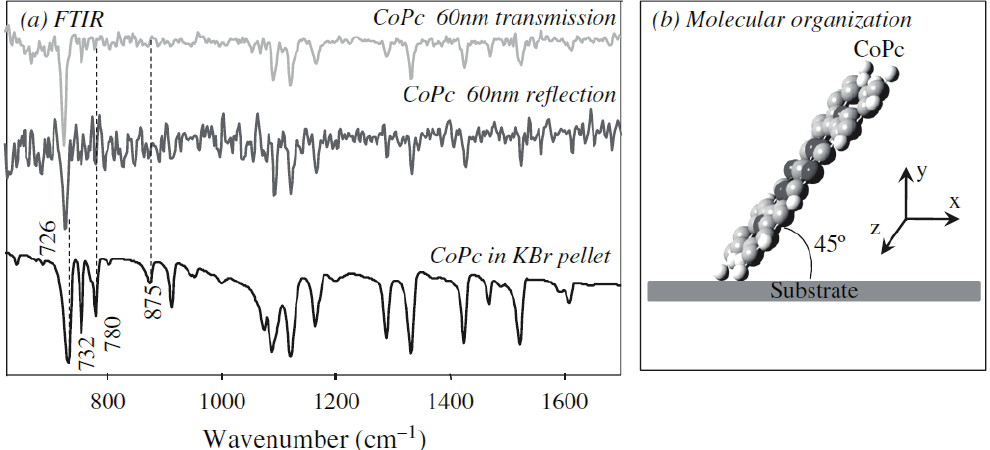
Figure 8 - ( a ) FTIR spectra recorded from CoPc powder in KBr pellet and 60 nm PVD fi lm deposited onto Ge (transmission mode) and Ag mirror (refl ection mode), ( b ) scheme of molecular organization proposed for CoPc in PVD fi lms. Reprinted with permission (Alessio et al. 2012).